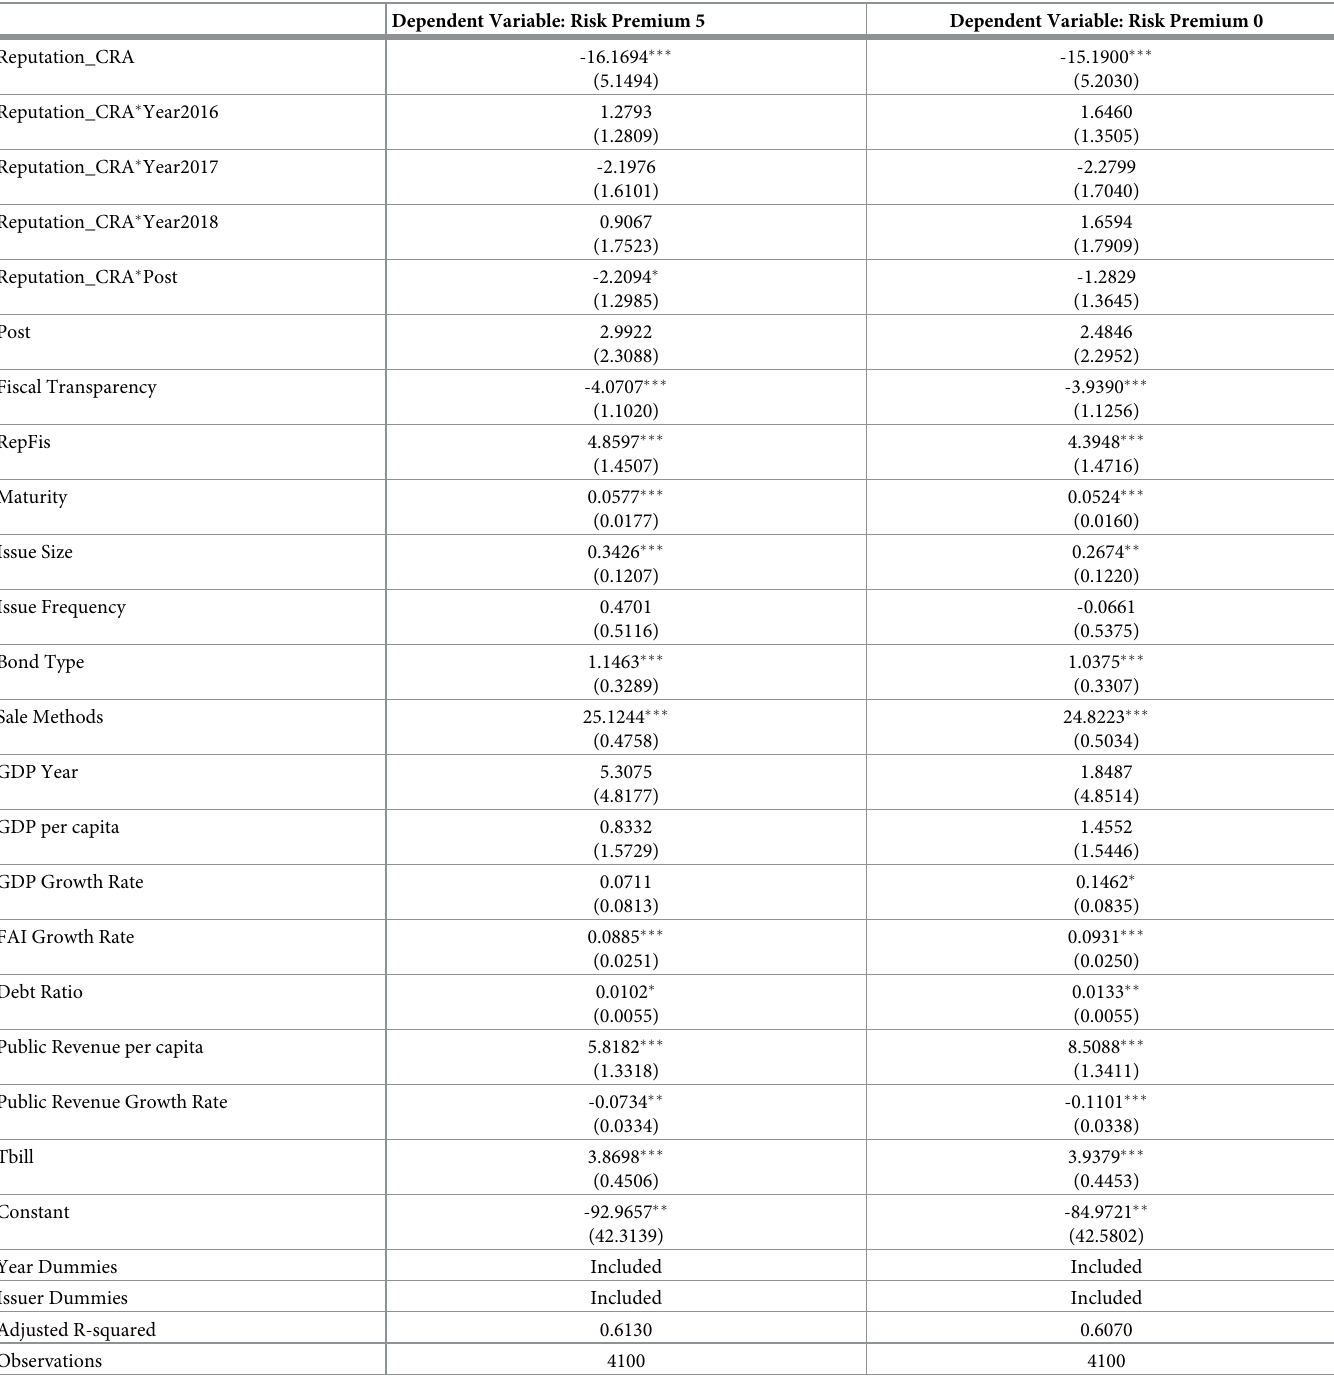
Table 12. Test of parallel trends assumption. This table reports the results for the test of parallel trends assumption for difference-in-differences OLS